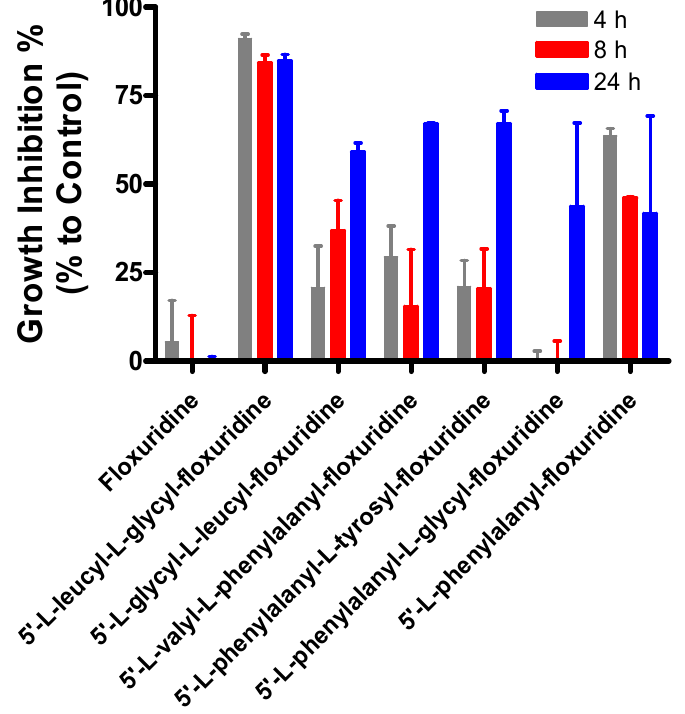
Figure 3. The growth inhibitory effects (%) of floxuridine prodrugs with varied post exposure time (4, 8, and 24 h). Values presented are the mean ± s.d. (n =